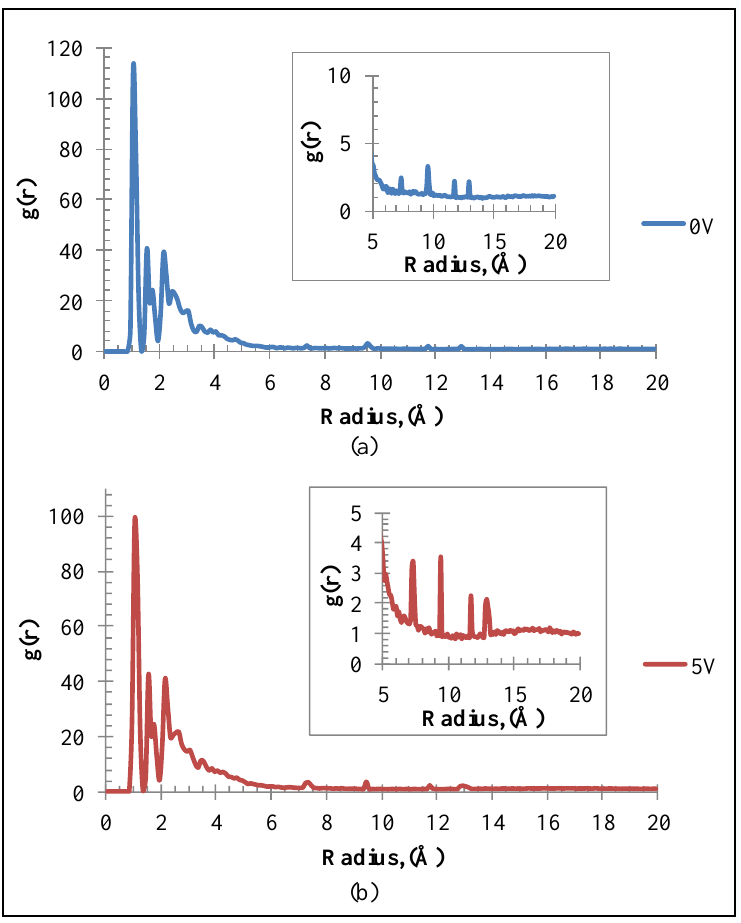
Figure 9. The RDF of the 44 g/L system for a simulation time of 50 ps with ( a ) an electric potential of 0 V at supersaturation of 1.28 and ( b ) with an electric potential of 5 V at supersaturation of 1.40. The insets are the enlarged results for interaction distance between 5 Å and 20 Å .